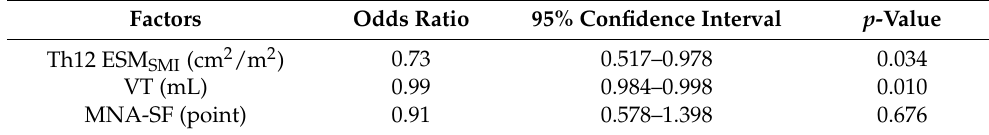
Table 3. Logistic regression analysis for energy malnutrition (RQ < 0.85).